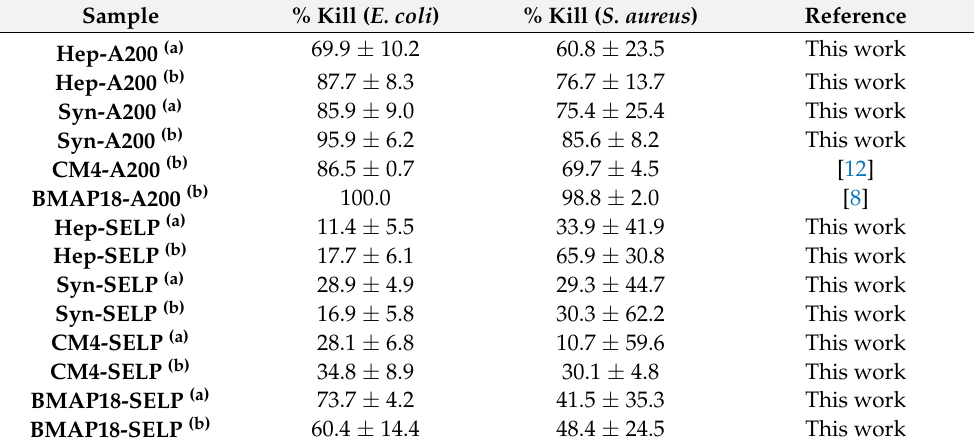
Table 2. Percentage lethality (% kill) of the different protein polymer films after 2 h incubation at 37 ◦ C with Escherichia coli and Staphylococcus aureus . Films were produced by solvent casting using (a) water and (b) formic acid as solvents. Experiments were performed in triplicate in independent days with three replicates each. Sample % Kill ( E. coli ) % Kill ( S. aureus ) Reference Hep-A200